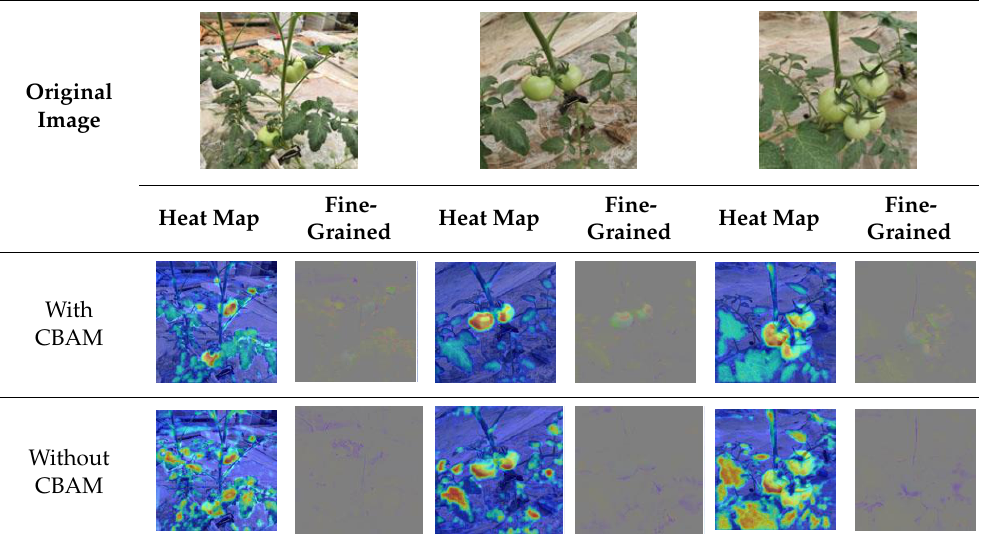
Table 4. Heat map and Fine-Grained map of feature extractor.